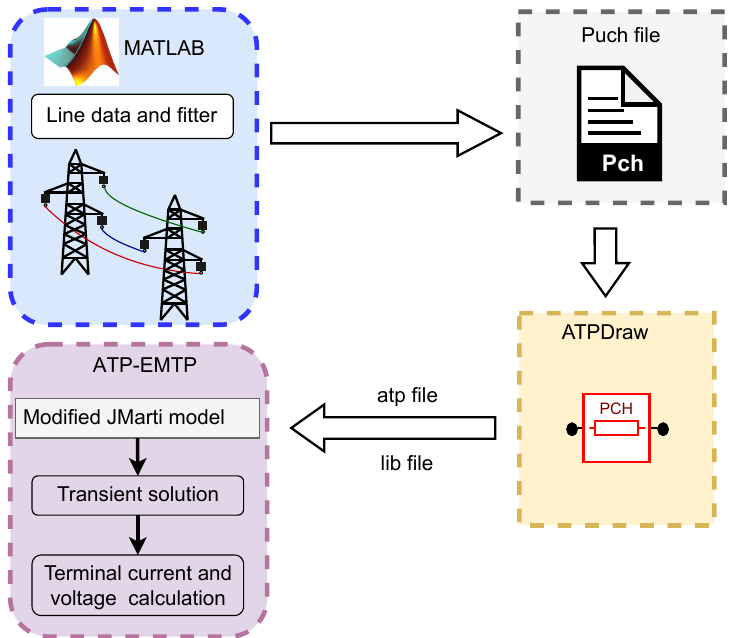
Figure 2. Diagram of the strategy used in the implementation of modified J. Marti model in ATP.